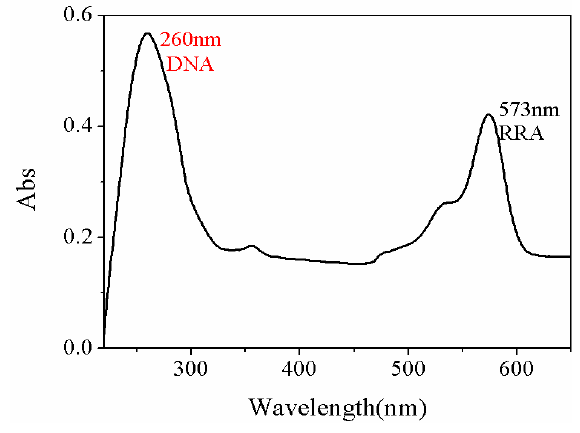
Figure 5. The UV-Vis absorption spectra of RRA-DNA.